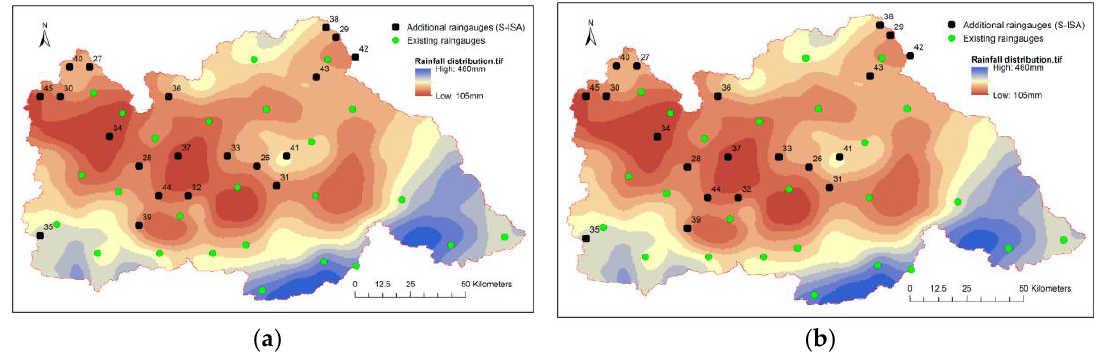
Figure 17. Optimal design of the S-ISA method. ( a ) Network of 60 rain gauges and ( b ) network of 45 rain gauges.